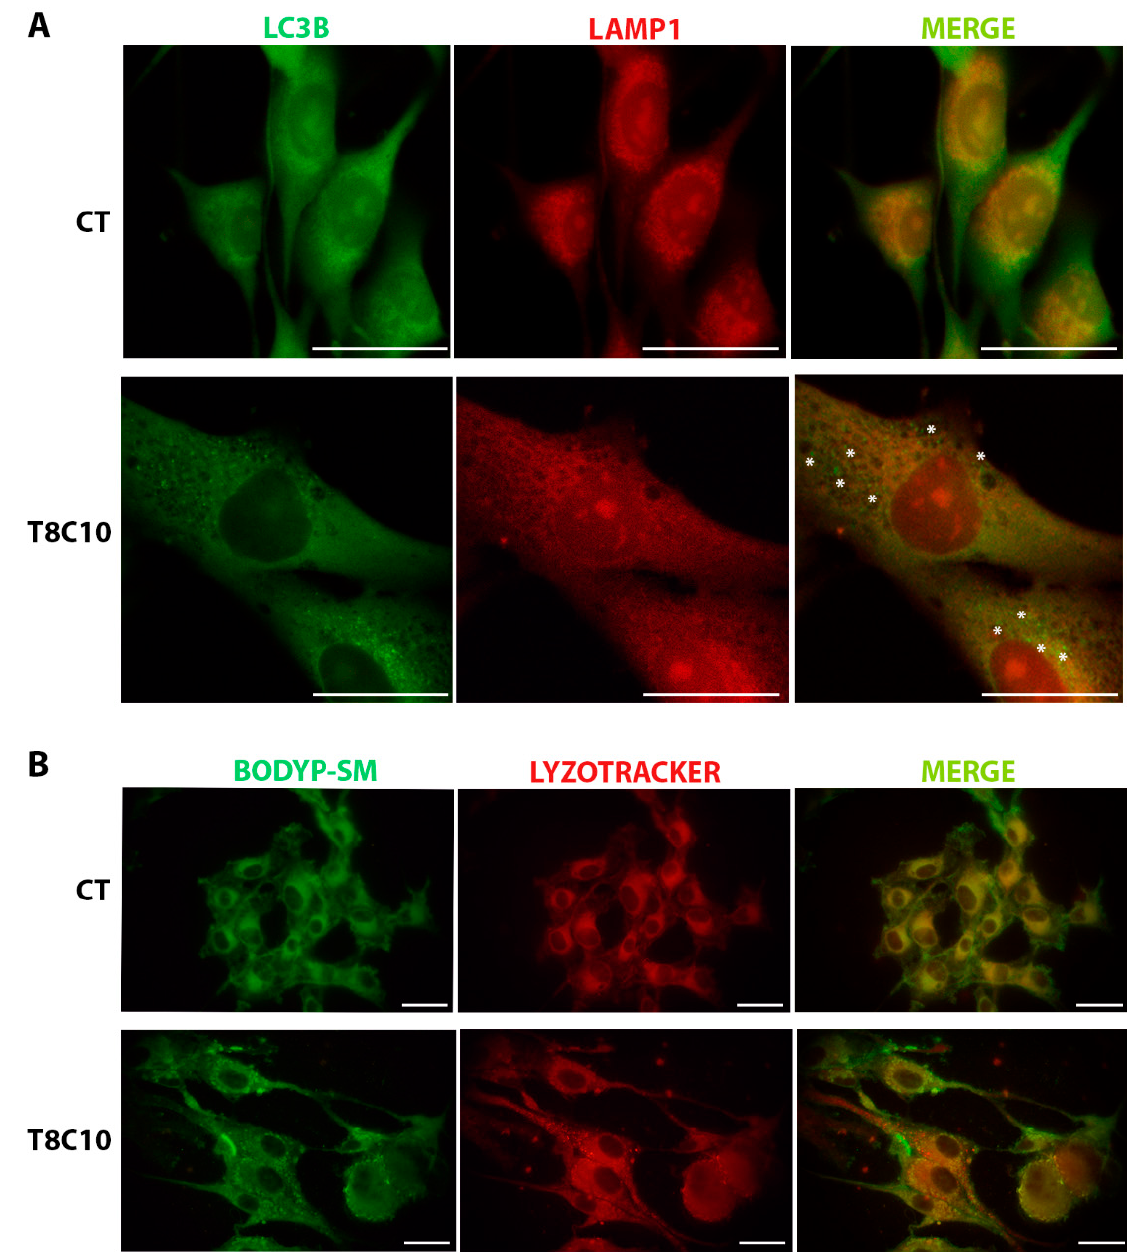
Figure 5. LC3 and LAMP1 colocalization and BODIPY-SM distribution were impaired following Hh and HDAC6 inhibition. ( A ) Double immunostaining against LC3 and LAMP1 of U87-MG cells treated in the presence or absence of both 8 µ M of TubA and 10 µ M of cyclo. Asterisks show some LC3 puncta, indicating autophagosomes, that did not colocalize with the red ones, indicating lysosomes. ( B ) BODIPY-SM and LysoTracker Red DND-99 staining of U87-MG cells treated in the presence or absence of both 8 µ M of TubA and 10 µ M of cyclo. CT—control, TubA/T—tubastatin A; cyclo/C—cyclopamine. Scale bar indicates 40 µ m. To investigate the possible effect of combination treatments in targeting SM-containing endosomes to lysosomes in U87-MG cells, we analyzed fluorescence distribution in the control and treated cells labeled with BODIPY-SM and Lysotracker Red (Figure 5B). In control cells after 30 min incubation, the fluorescence of BODIPY-SM and that of LysoTracker Red almost completely colocalized in the perinuclear region indicating that endocytosed fluorescent SM was correctly addressed to lysosomes. In treated cells, the